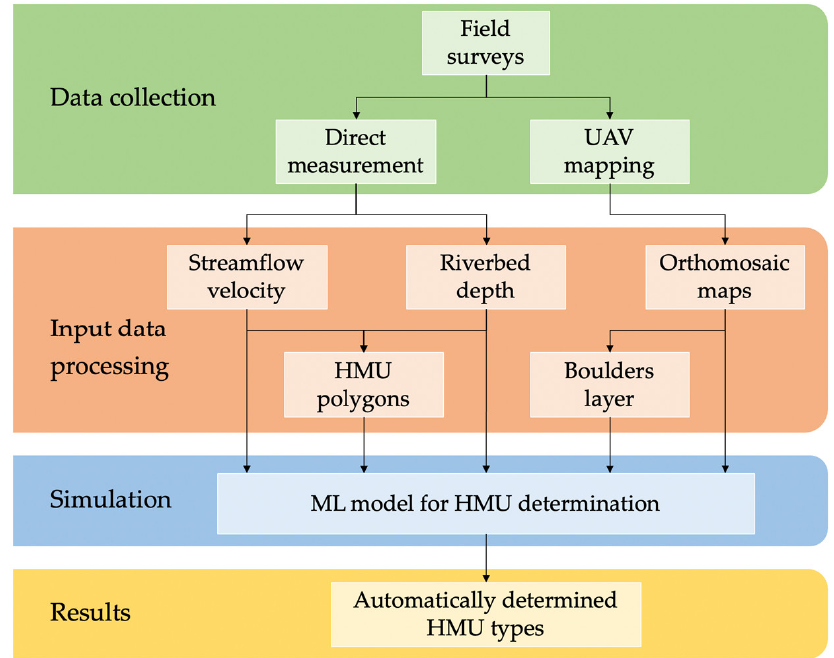
Figure 2. The workflow scheme of this research.